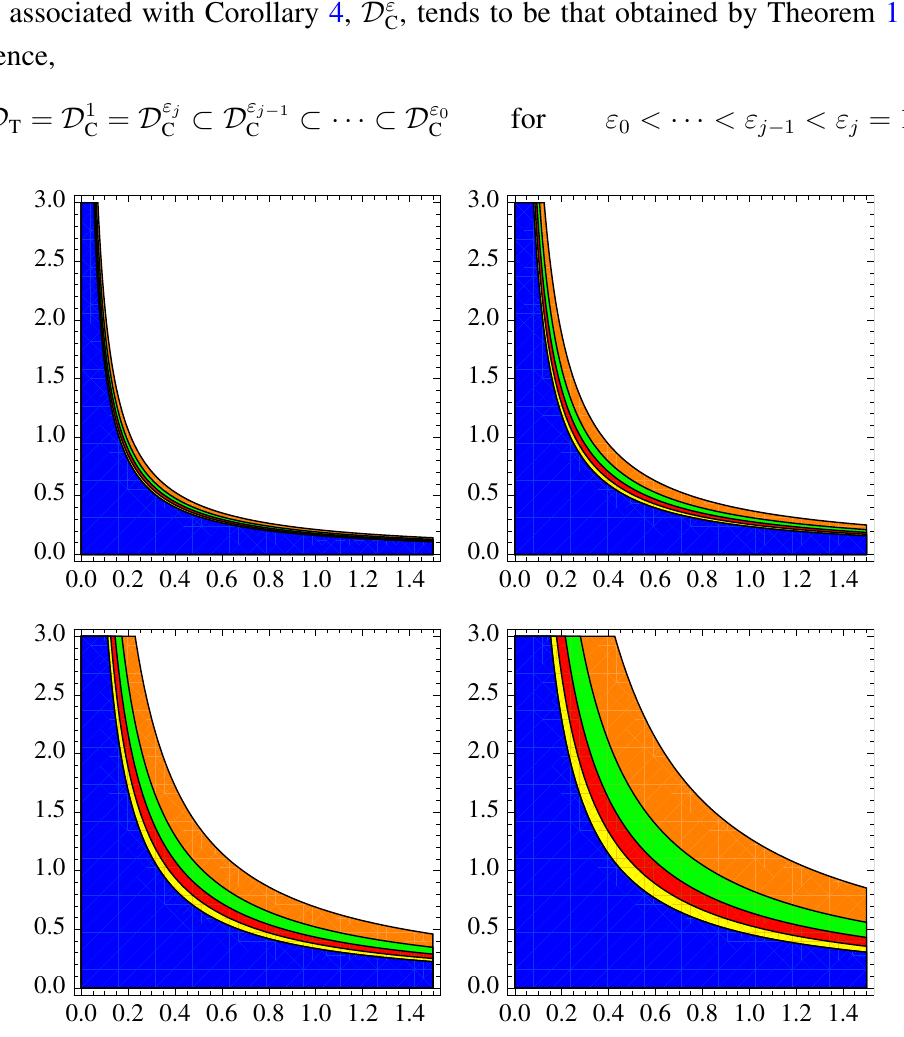
Figure 1. Domains of parameters of Newton’s method associated with Theorem 1 (blue region) and Corollary 4 (orange for ε = 0 . 1 , green for ε = 0 . 2 , red for ε = 0 . 4 and yellow , 1 , 2 , 4 for ε = 0 . 8 ) for p = 1 10 5 5 5